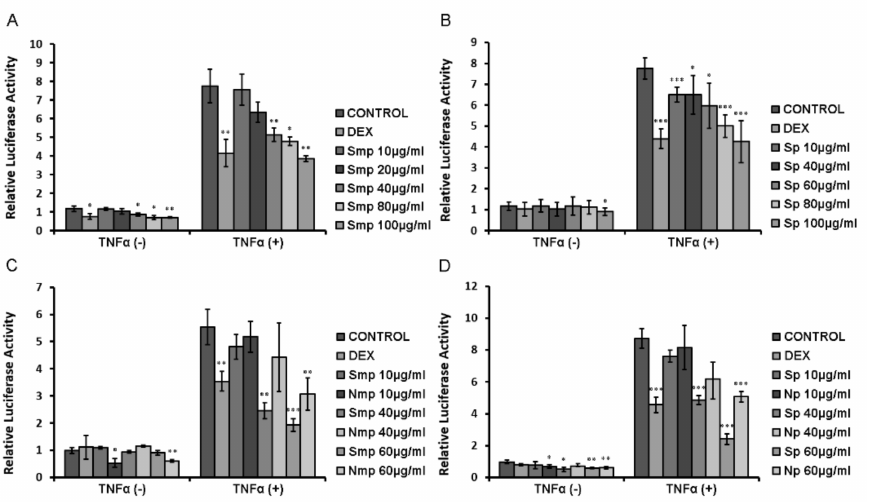
Figure 6. Suppression of the TNF α -induced NF- κ B transcriptional activation by South ( A , B ) and South versus North ( C , D ) mp and p fractions of Chios mastiha tree leaves, in HEK293 cells. Luciferase and β -galactosidase activity was measured in cell extracts from HEK293 cells cultured in hormone- depleted medium, transiently co-transfected with an NF- κ B-Luc reporter gene construct and a β -galactosidase reporter construct and subsequently treated with 5–100 µ g/mL leaves fractions and/or 20 ng/mL TNF α , for 6 h. Control cells were treated with DMSO (1:1000). Relative luciferase activity was expressed as normalized luciferase activity against β -galactosidase activity. Data are expressed as the mean ± SD, ( n = 3–6), * p < 0.05; ** p < 0.01; *** p < 0.001.